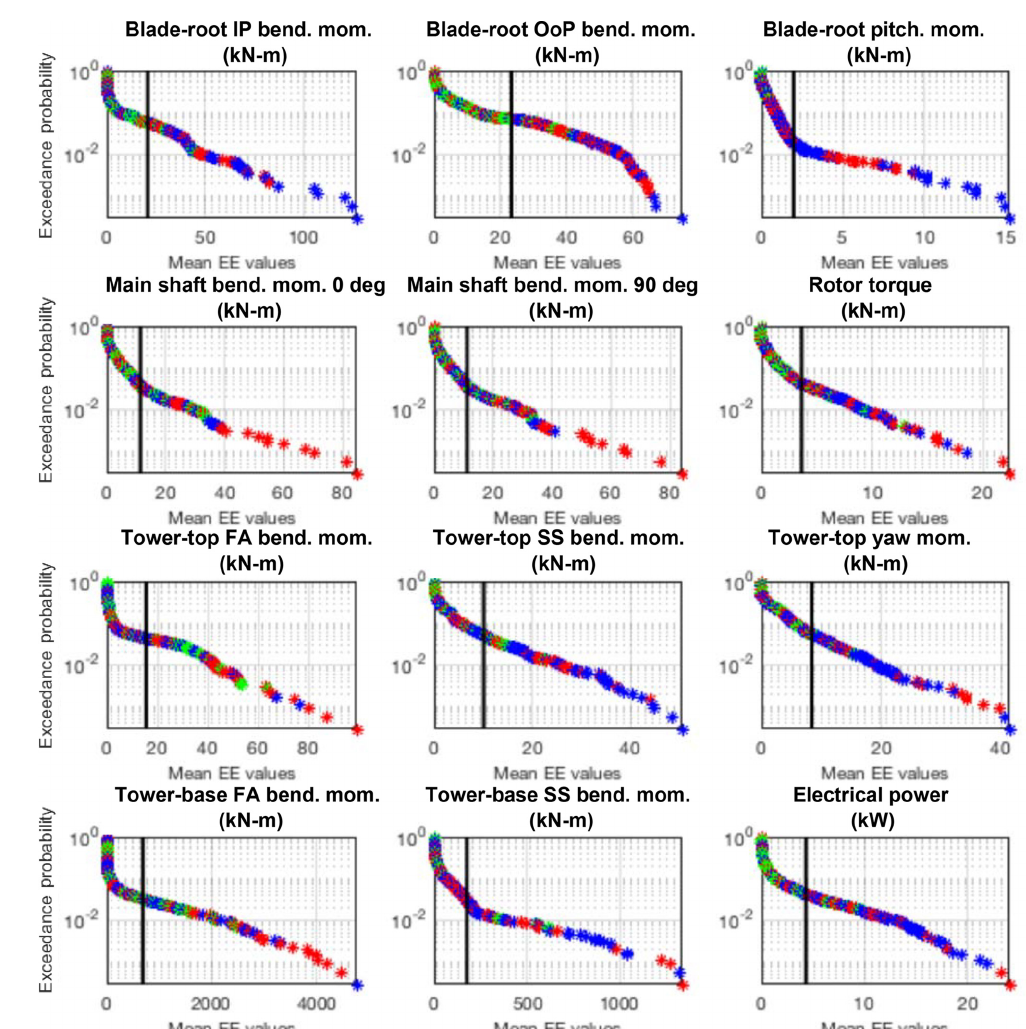
Figure B4. EE-value exceedance probability plots of fatigue loads of aeroelastic turbine parameters across all wind speed bins, input parameters, and simulations points for all QoIs. The black line represents the defined threshold by which outliers are counted for each QoI. Color indicates wind speed bin (blue is below-rated speed, red is near-rated speed, green is above-rated speed).